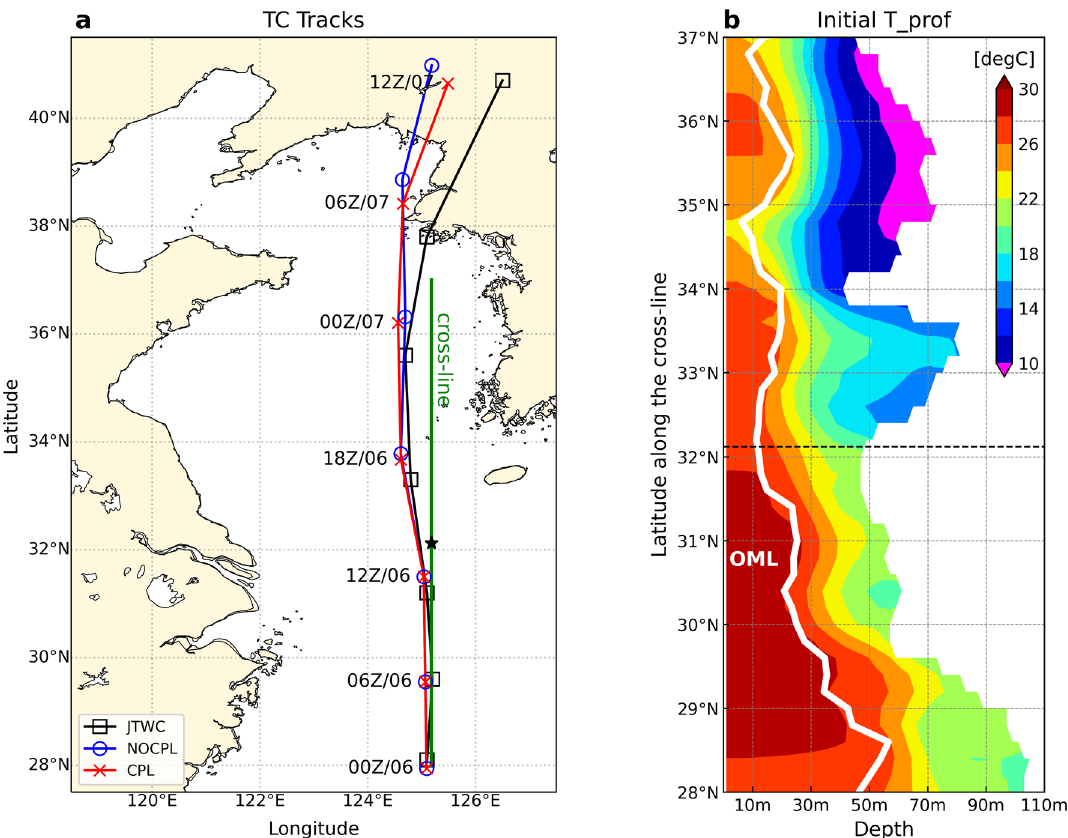
Figure 2. ( a ) Simulated typhoon tracks from different model configurations in the NOCPL (blue circle) and CPL (red cross) along with the JTWC reported best-track (black square) for Typhoon Lingling (2019). The meridional green line indicates the cross-line in 28–37° N at 125.18° E. The black star indicates the location of the Ieodo ORS. ( b ) The latitude-depth profile of the initial water temperature (°C; shaded) and OML depth (thick white line) at 00Z on September